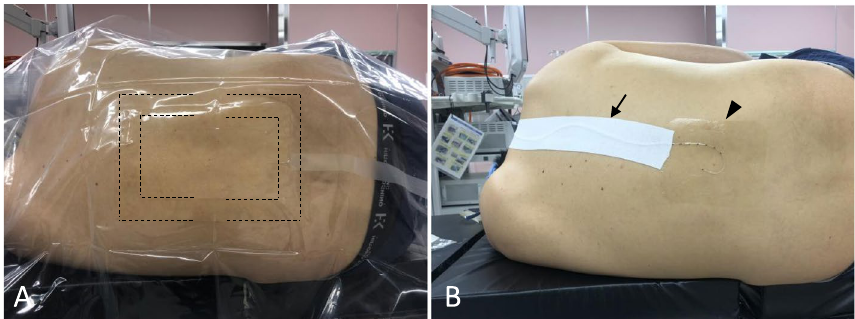
Fig. 1 Preparation of epidural tubing in our hospital. In A , the black dotted lines and black arrows indicate the tape of the surgical drape. In B , the black arrow and arrowhead indicate the tape used to secure the epidural catheter and a film dressing, respectively